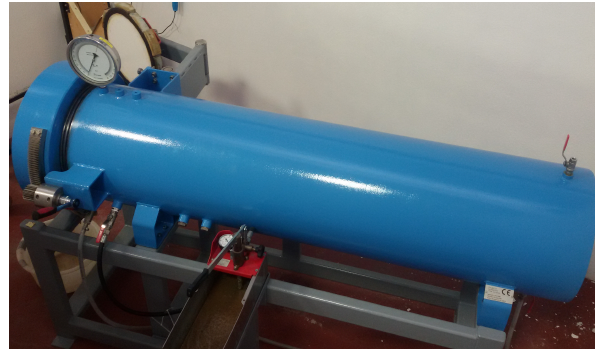
Figure 11. MDM Lab pressure